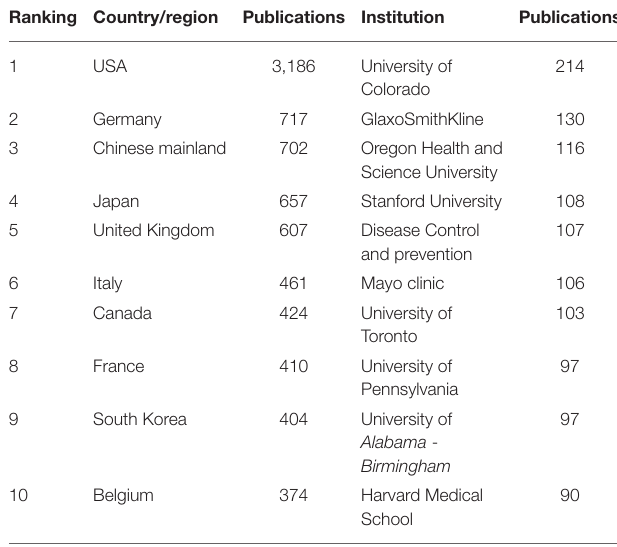
TABLE 1 | Top 10 countries/region and institutions in terms of publications for herpes